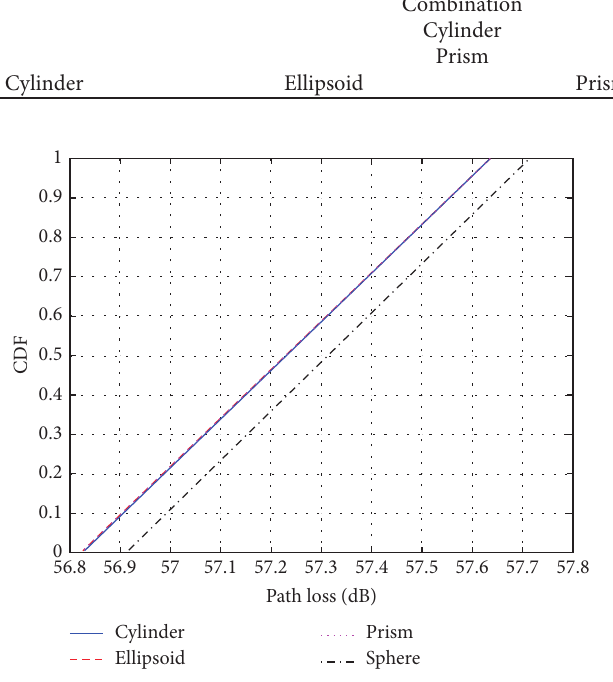
Figure 10: CDFs of the PL with the Rx closing to the left ear. Table 10: Simulation and measurement results around the head.